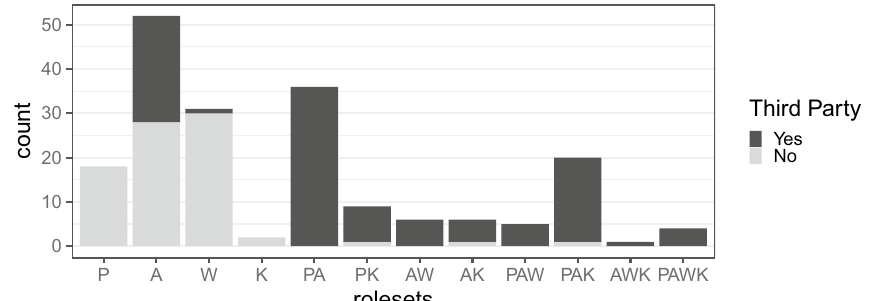
Fig. 3 Graphical representation of distribution of combination of role structures with presence of third